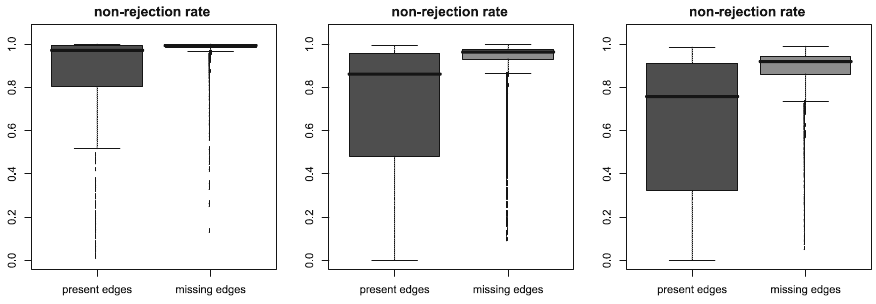
G with n = 20, q = 10. 1